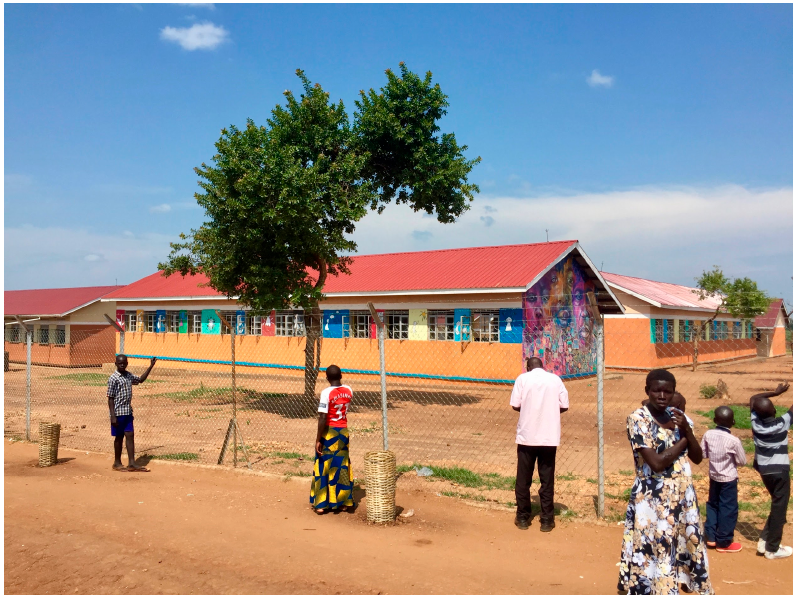
Figure 5. This is one of the elementary schools in Bidi Bidi. Photograph taken by Tim Berke, 2019.